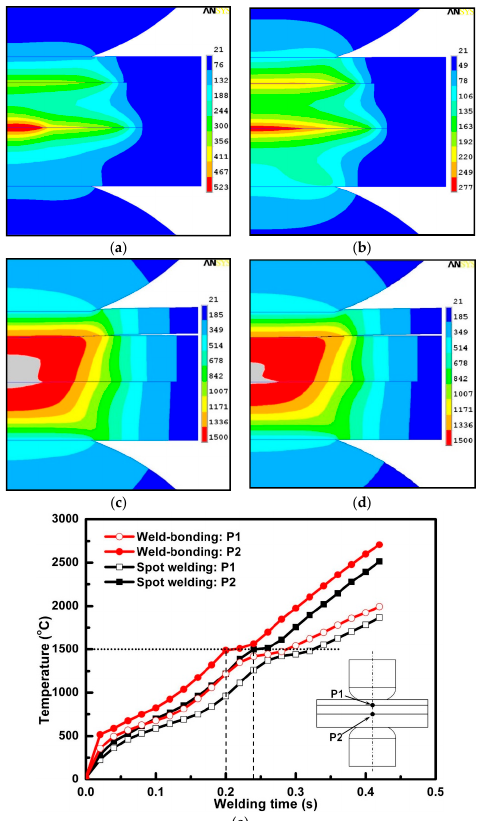
Figure 11. Comparison of the calculated temperature histories between the weld-bonding of Terokal 5089 and the spot welding (Legends in a–d donates the temperature with degree ◦ C). ( a ) weld-bonding @ 20 ms; ( b ) spot welding @ 20 ms; ( c ) weld-bonding @ 240 ms; ( d ) spot welding @ 240 ms; ( e ) Calculated temperature histories of weld-bonding and spot